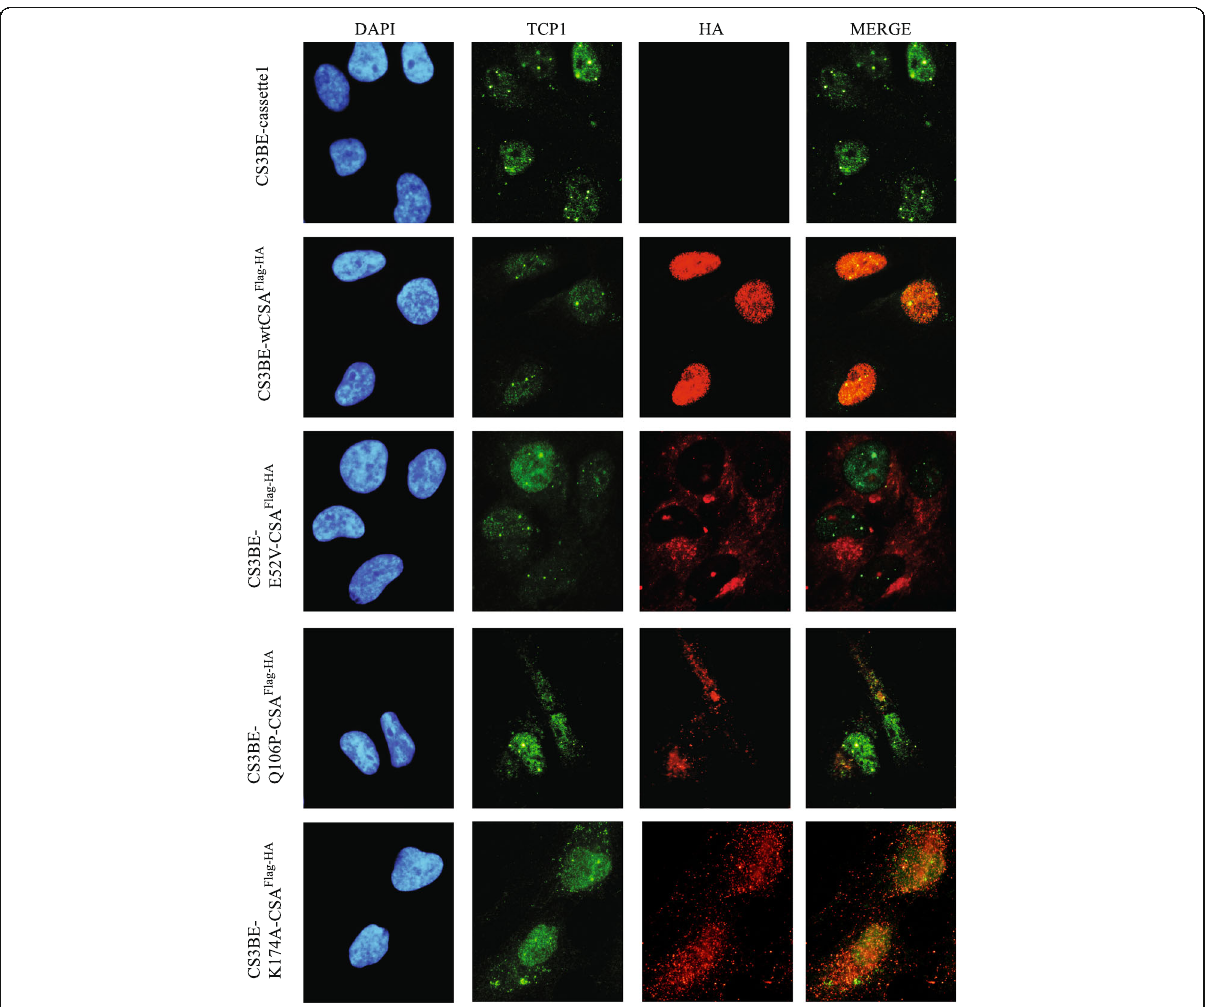
Fig. 3 Subcellular co-localization of the recombinant CSA Flag-HA proteins with TCP1 subunit. Double immunofluorescence staining with anti-HA antibodies ( red ) and anti-TCP1 ( green ) in CS3BE-cassette1, CS3BE-wtCSA Flag-HA , CS3BE-E52V-CSA Flag-HA , CS3BE-Q106P-CSA Flag-HA , and CS3BE-K174A- CSA Flag-HA . Nuclei were counterstaining with DAPI ( blue